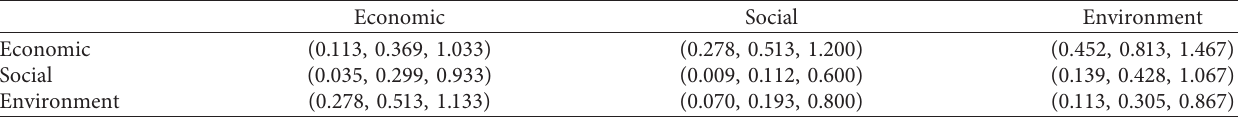
Table 36: Total relationship matrix of sustainability dimensions in fuzzy